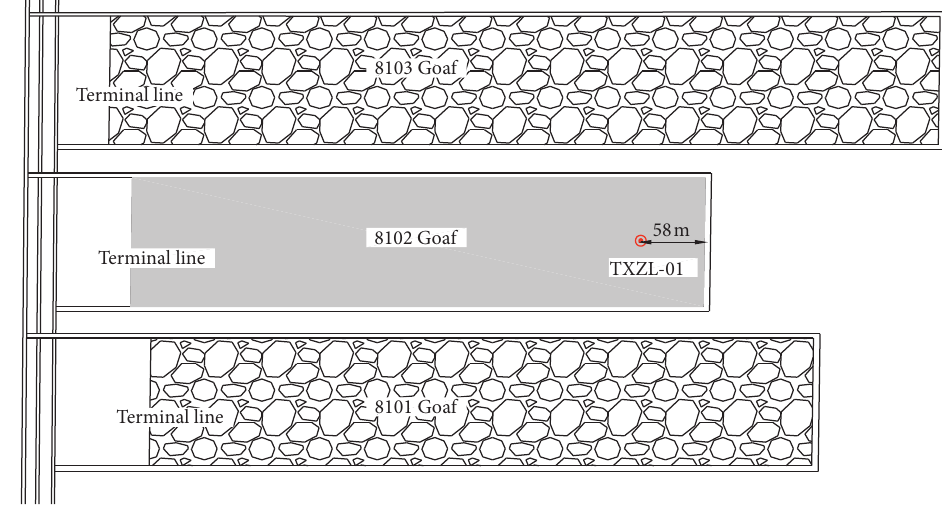
Figure 7: Relationship between fractured well and working